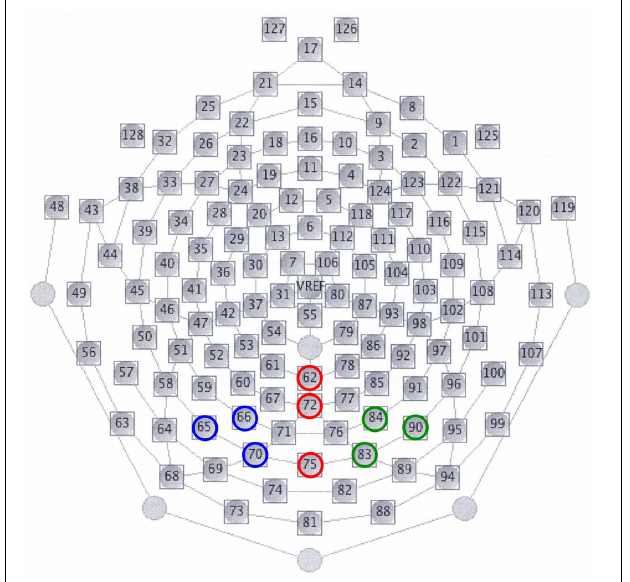
FIGURE 3 | Selected electrodes of interest for vMMNs. Electrode numbers 65, 66, and 70 constitute the left occipitotemporal region (blue circles), numbers 62, 72, and 75 the mid-occipitoparietal region (red circles), and numbers 83, 84, and 90 the right occipitotemporal region (green circles). Note that electrodes 62, 75, 58, and 96 correspond to Pz, Oz, T5, and T6 in the international 10–20 system of EEG, respectively.